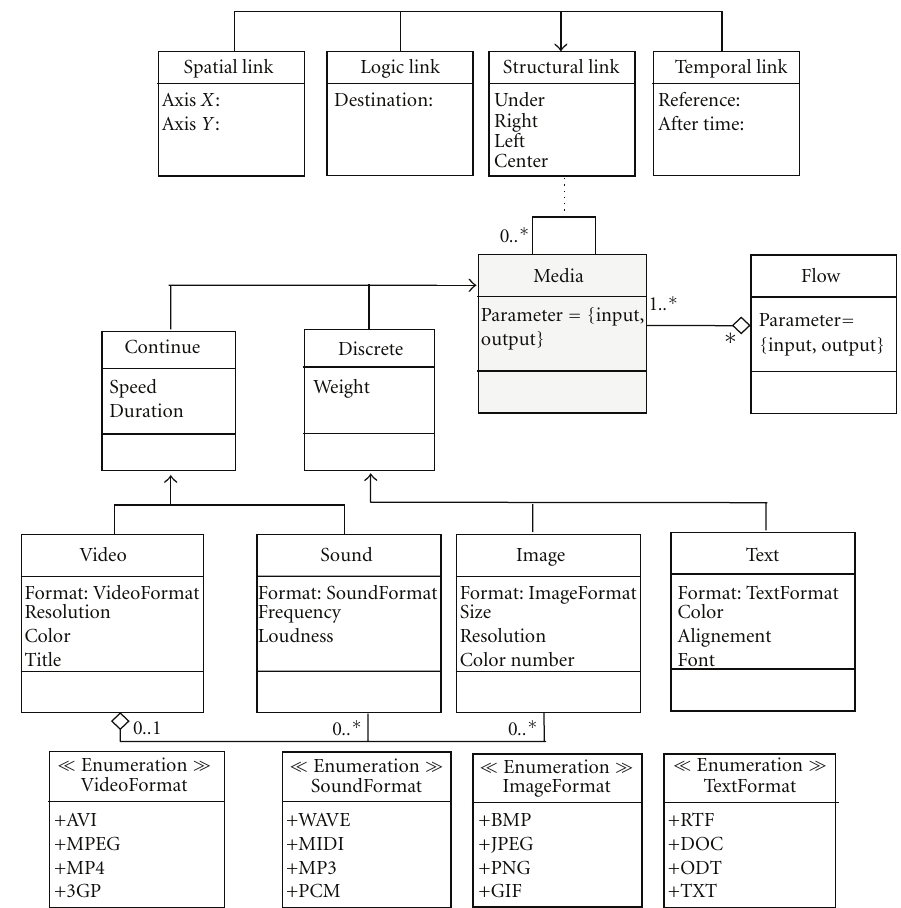
Figure 1: Multimedia flow model for